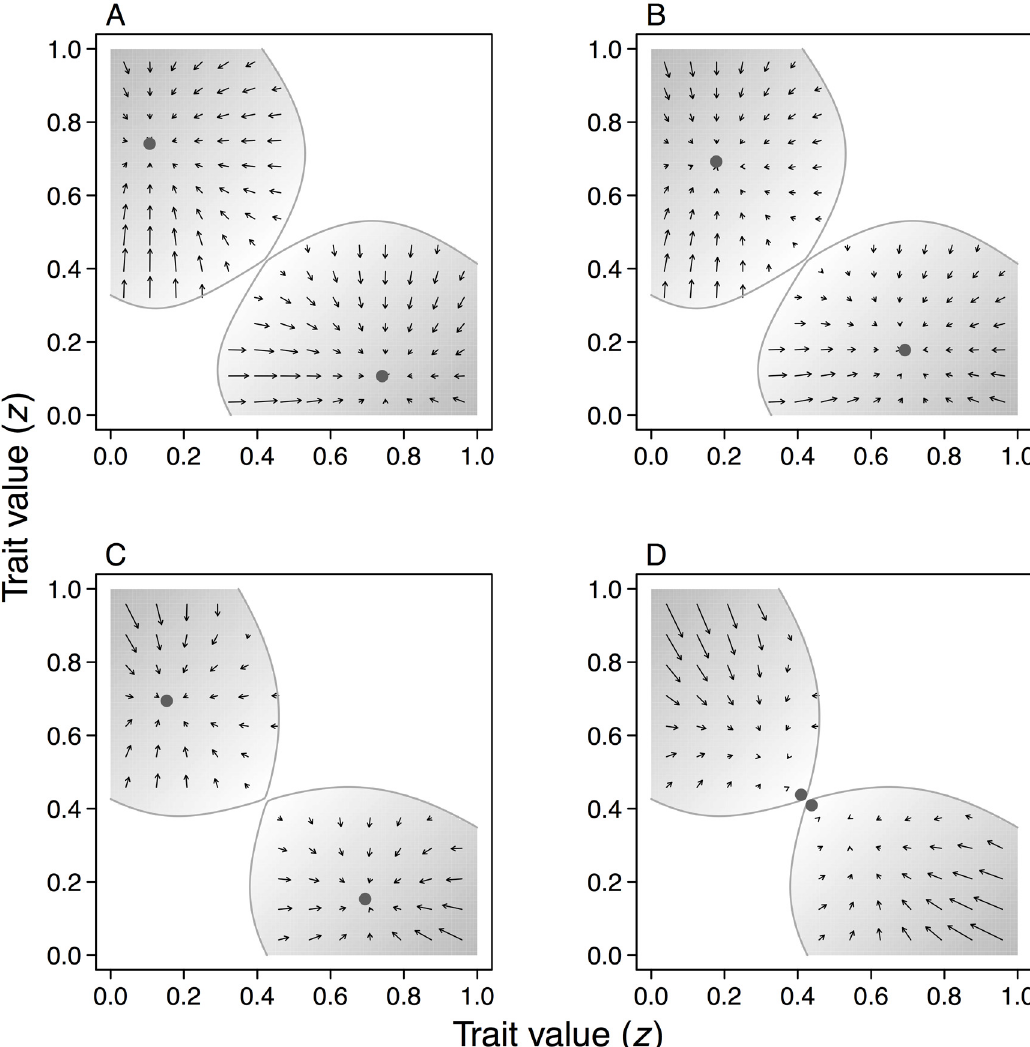
Fig 3. Trait evolution plots for dimorphisms. In each example, the shaded region shows where a dimorphism z 1 , z 2 can be maintained, the arrows indicate the direction and magnitude of the selection gradient Eq (7), and the dots show evolutionarily equilibrium dimorphisms. The examples differ in between-habitat migration rate m 12 = m 21 = m and rate of recombination ρ . (A) m = 0.05, ρ = 0.001; (B) m = 0.05, ρ = 0.5; (C) m = 0.10, ρ = 0.001; (D) m = 0.10, ρ = 0.5. Other parameters: N 1 = 20 and N 2 = 2, W 1 = W 2 = 0.5, b 1 = b 2 = 3.0, c 1 = c 2 =